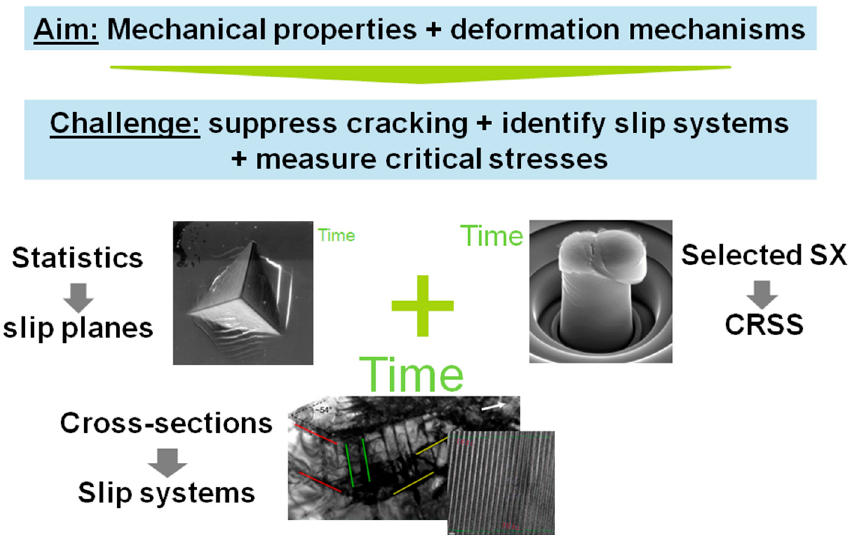
Figure 1. Typical combination of methods employed to unravel the mechanical properties and underlying deformation mechanisms in materials where these might not be fully understood or known at all. Their order and selection is normally based on the investigative depth, e.g., hardness versus a critical resolved stress on an individual slip system, time, and cost.